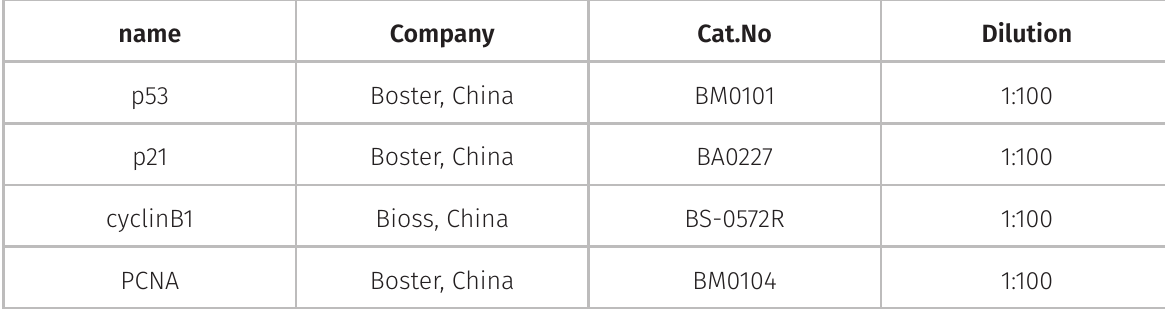
Table II. Antibodies used in immunohistochemistry